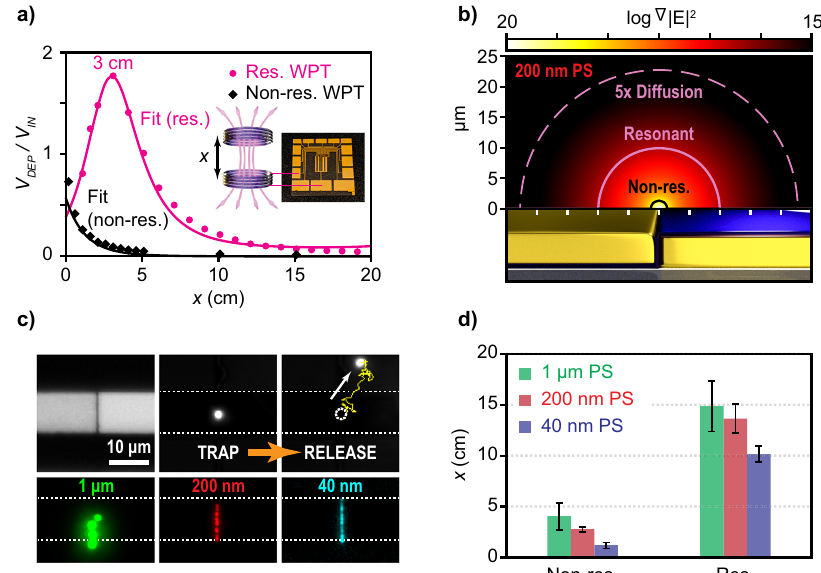
Non-res. distribution of the gradient of the E- fi eld squared is plotted for reference. c Microscope images of the coplanar DEP device during wireless trapping of 1 µ m, 200nm,and40nmPSparticles.Thetopleftimageisabright- fi eldimageoftheDEP coplanar device. The other top images depict wireless trapping and releasing of a 1 µ m particle as the coil separation is increased beyond suf fi cient power cou- pling for trapping. The bottom three fl uorescent images show the trap site loaded with their indicated particle size. See Supplementary Materials and Figure S4 for trap and release data of the 200nm and 40nm PS beads. d Experimental results comparing the maximal coil separation, x, in which trapping of 1 µ m, 200nm, and 40nm PS particles could be maintained for non-resonant and resonant operation. The distancebetweenthe coils isnearly 3×farther when using resonant operation. Error bars indicate ±one standard